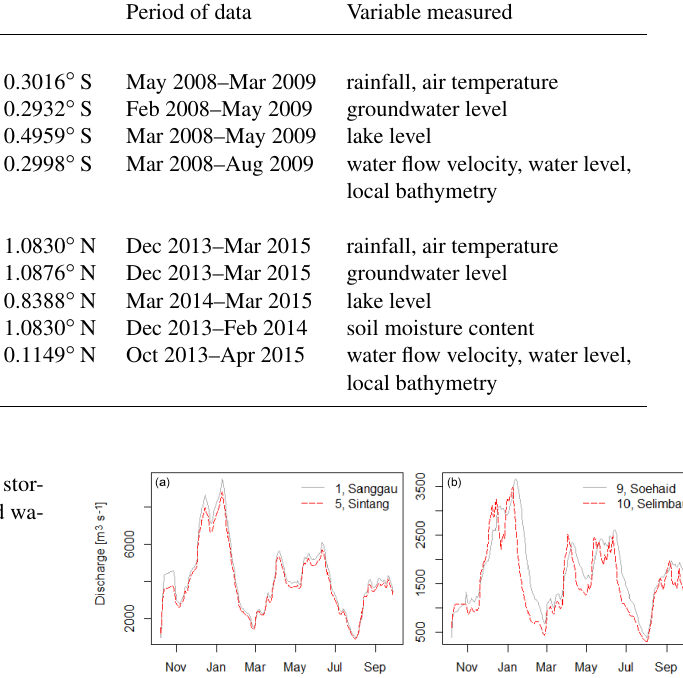
Figure 4. HEC-RAS simulated discharges for different cross sec- tions in the downstream Kapuas River (a) and the upstream Kapuas River (b) of the modelled river